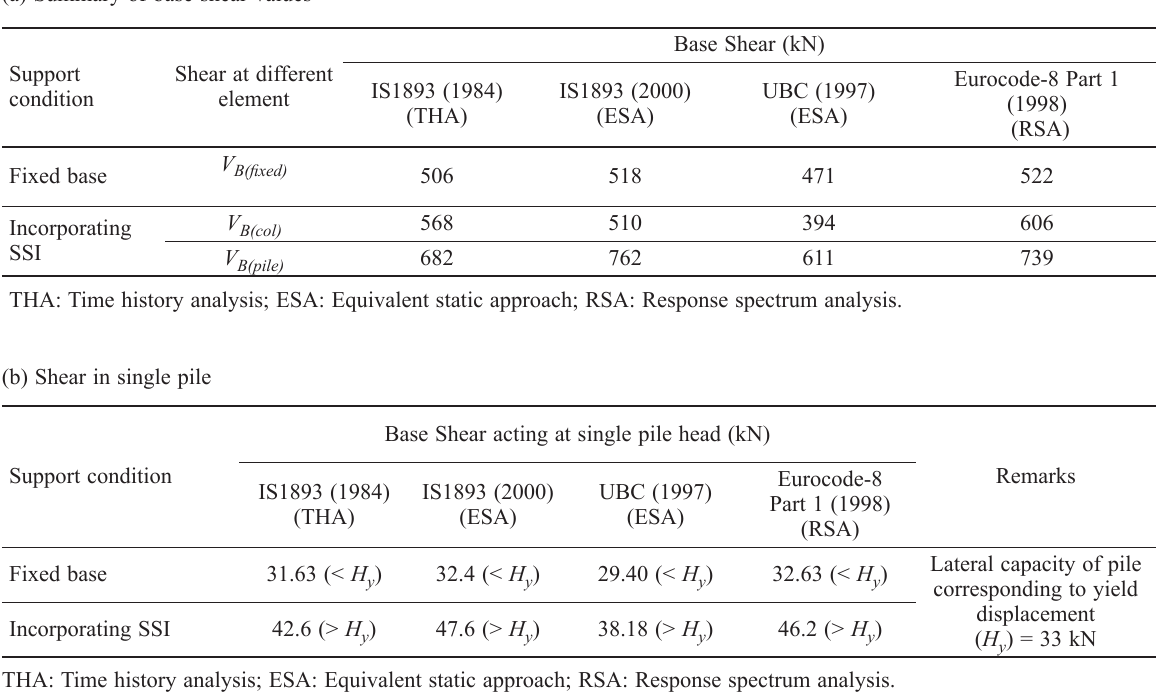
Table 9. Results for example case